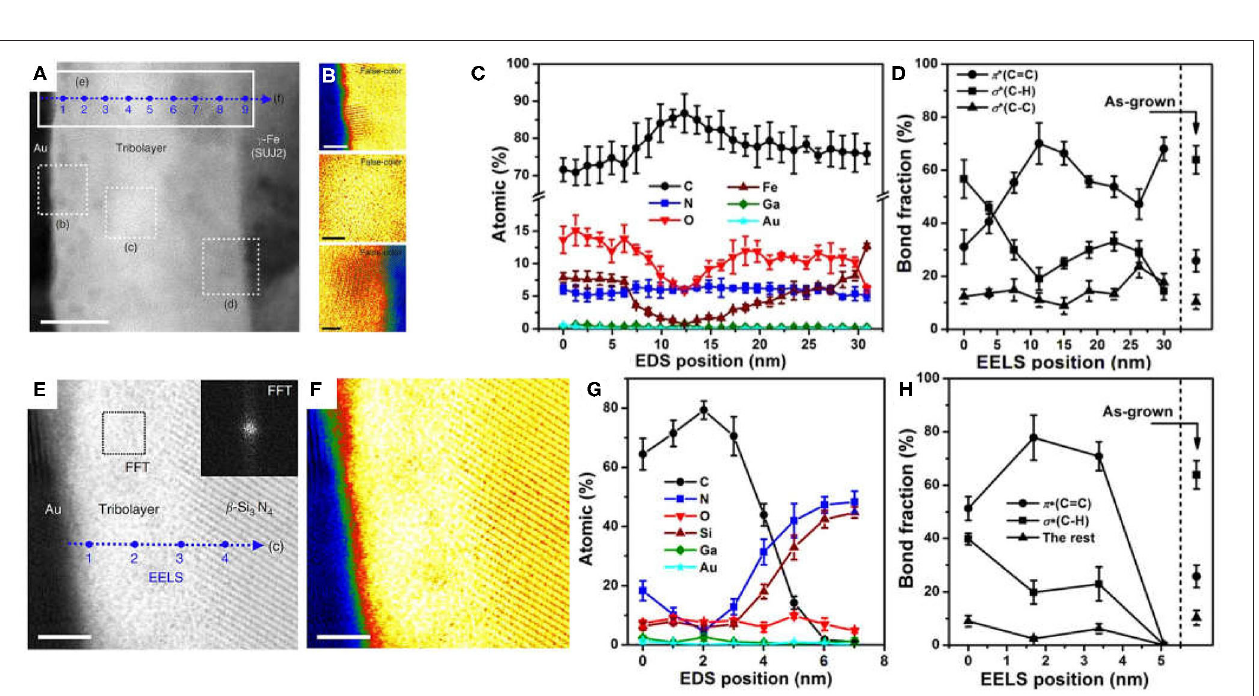
FIGURE 11 | (A–D) Characterization of tribolayer generated on the ball surface for the friction pair of bare SUJ2 ball and a-C:H films. (A) BF-STEM image showing a tribolayer of ∼ 27nm generated on the SUJ2 ball. (B) False-color displayed BF-STEM images of three individual sublayers marked in (A) . (C) The evolution of elemental composition across the tribolayer marked in (A) . (D) Evolution of the calculated EELS C-bonds fractions across the tribolayer as marked in (A) . (E–H) Characterization of tribolayer generated on ball surface for the friction pair of bare Si 3 N 4 ball and a-C:H film. (E) BF-STEM image showing a tribolayer of ∼ 5nm generated on the Si 3 N 4 ball. (F) False-color displayed BF-STEM images of (E). (G) The evolution of elemental composition across the tribolayer marked in (E) . (H) Evolution of the calculated EELS C-bonds fractions across the tribolayer as marked in (E) . Adapted with permission from Chen et al. (2017) Copyright 2017, the authors.